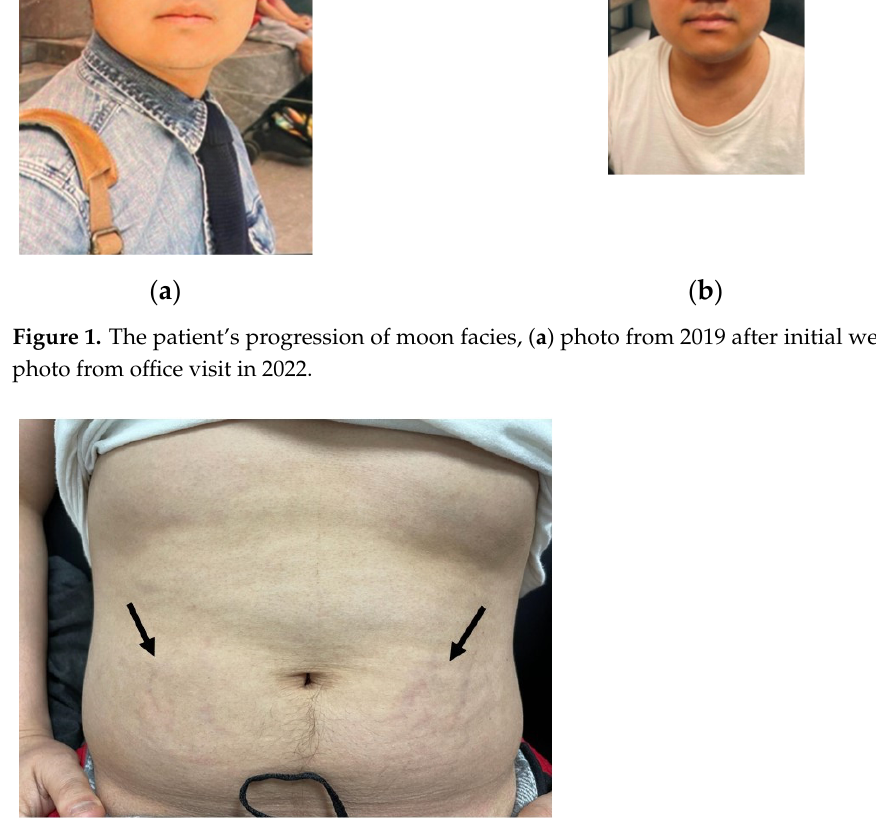
Figure 2. The arrows demonstrate early striae visualized on the lower abdomen bilaterally, unclear in image due to poor office lighting.